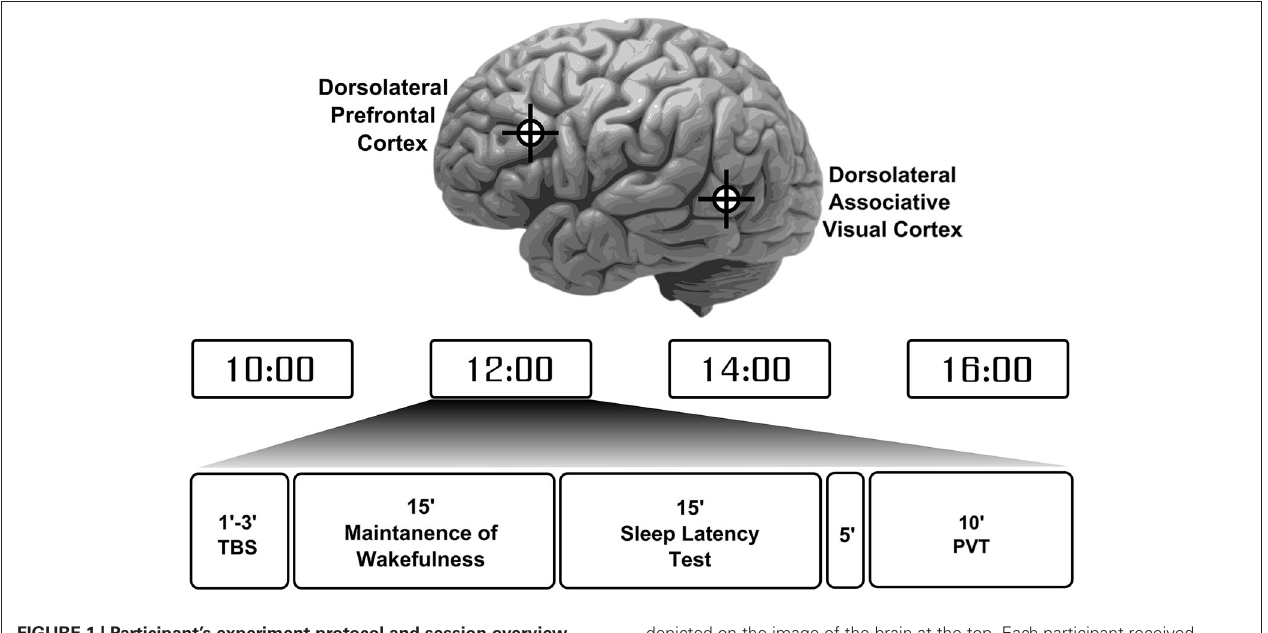
FIGURE 1 | Participant’s experiment protocol and session overview . Participants completed a total of 4 sessions throughout the day in evenly spaced times between 10 am to 4 pm. Each session started with theta-burst stimulation (TBS) to either the left dorsolateral prefrontal cortex or the left dorsolateral associative visual cortex in an alternating fashion with the location for first stimulation chosen at random. These locations are